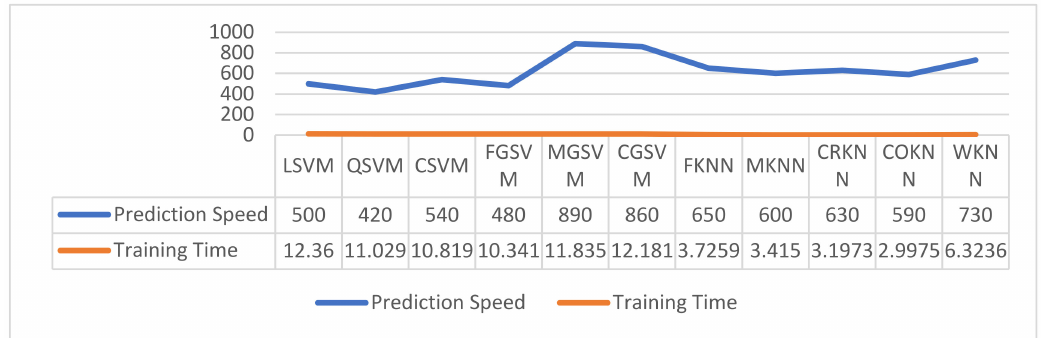
Figure 15. Proposed model training time (s) and prediction speed (obs/s) on back views of PKU-Reid dataset utilizing 1000-feature subset.